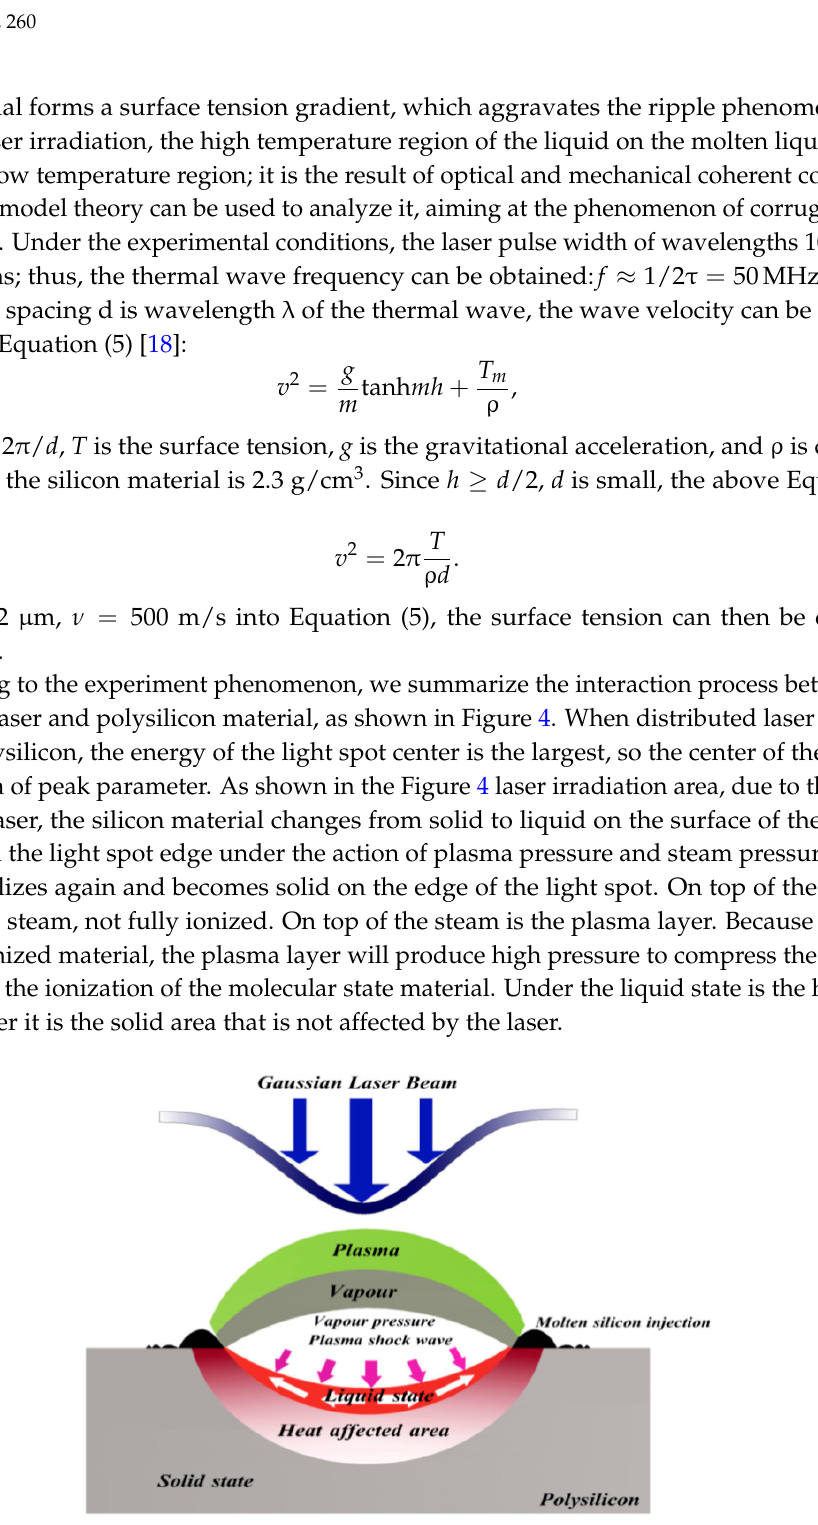
Figure 4. Schematic diagram of irradiation upon the polysilicon of the pulse laser.